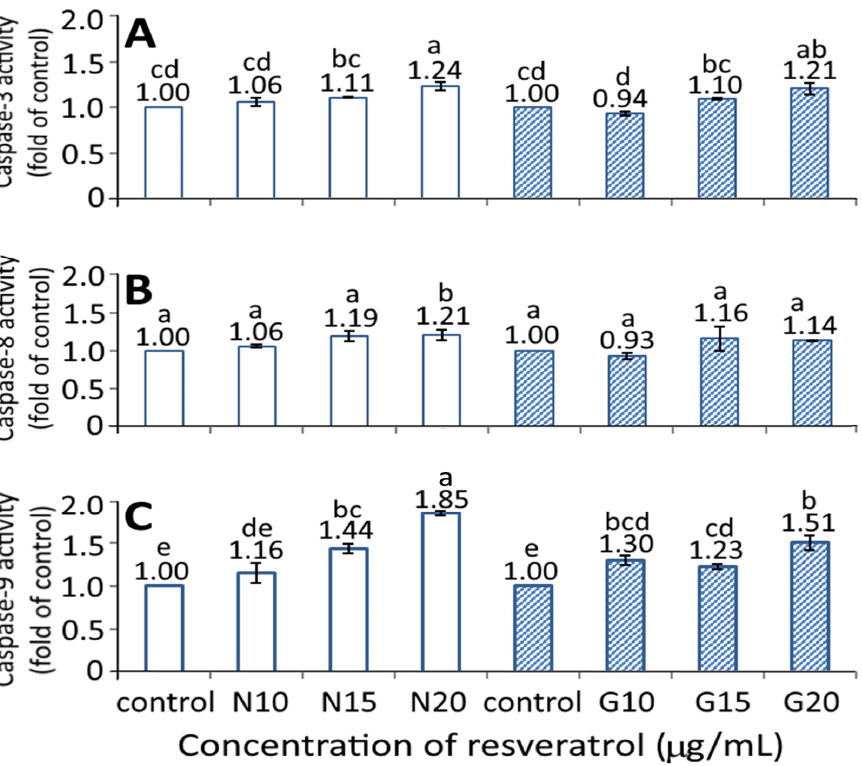
Figure 7. Effect of different concentrations (10, 15, and 20 µg/mL) of resveratrol nanoemulsion and resveratrol-gold nanoparticles on caspase-3 ( A ), caspase-8 ( B ), and caspase-9 ( C ) activities of pancreatic cancer cells BxPC-3. Control represents that cells were incubated in RPMI medium containing blank nanoemulsion without resveratrol ( ) and gold nanoparticles without resveratrol ( ). N and G represent resveratrol nanoemulsion and resveratrol-gold nanoparticles, respectively. Data are shown as mean standard deviation ( n = 3) and data with different small letters (a–e) are signifi- cantly different at p < 0.05.